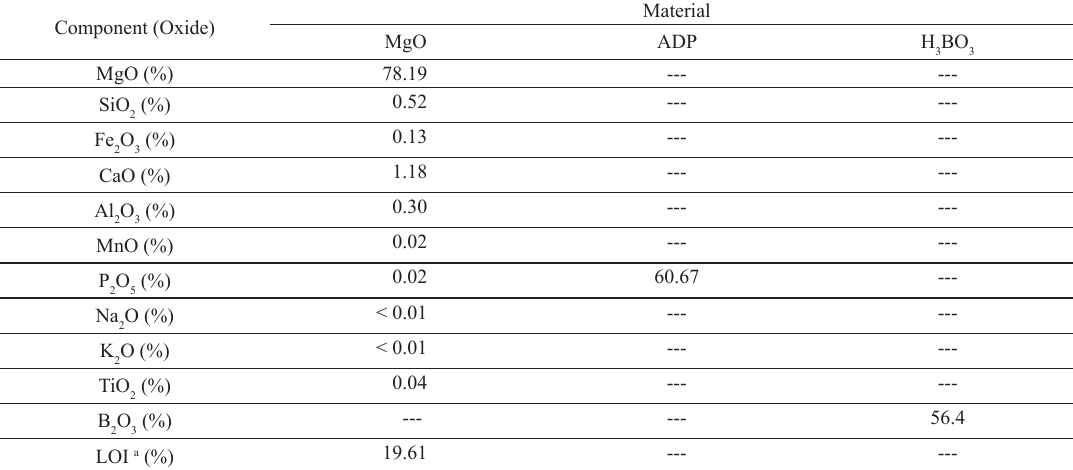
H PO , ADP) and boric acid 4 2 4